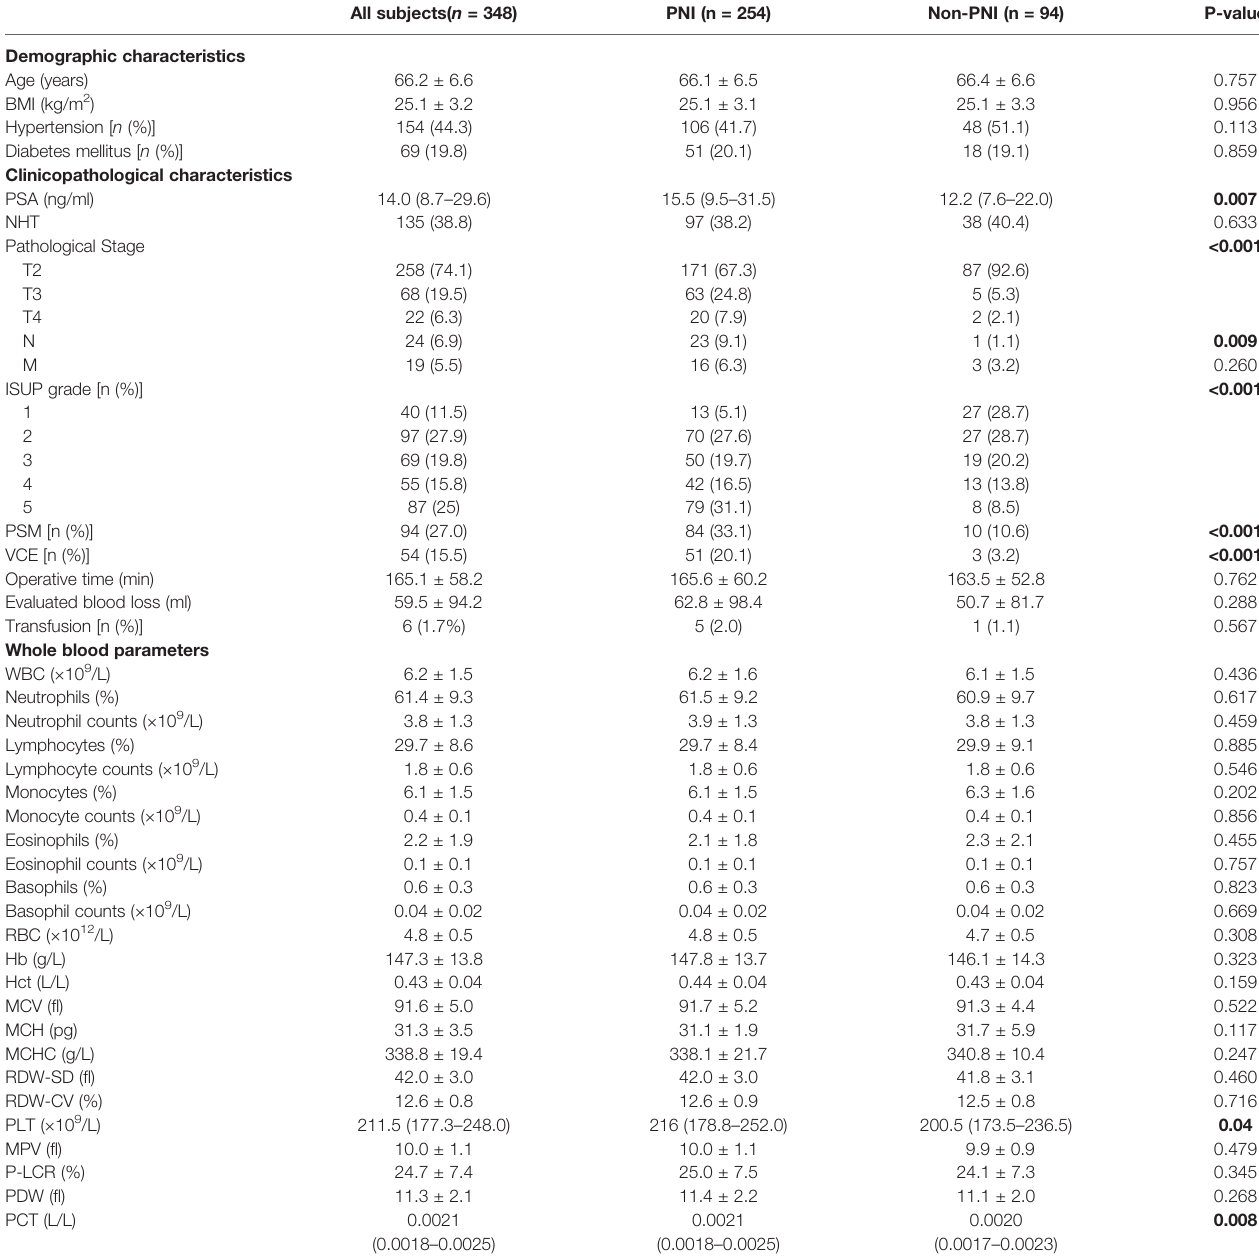
TABLE 1 | Baseline characteristics of the PCa subjects underwent RP according to the PNI strati fi cation. All subjects( n = 348) PNI (n = 254) Non-PNI (n = 94) P-value Demographic characteristics Age